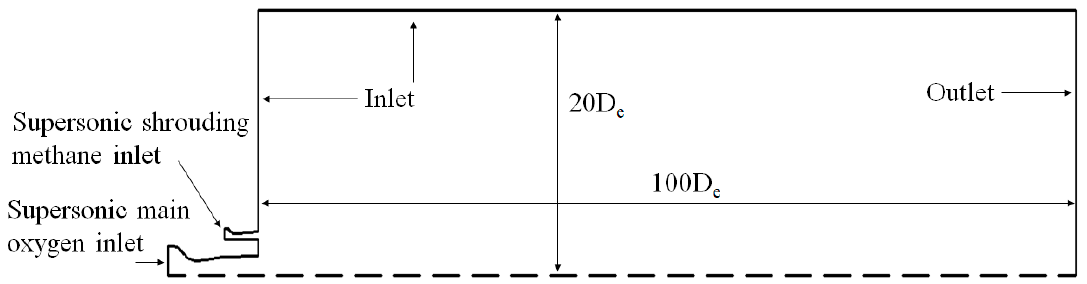
Figure 3. Computational domain with boundary conditions.